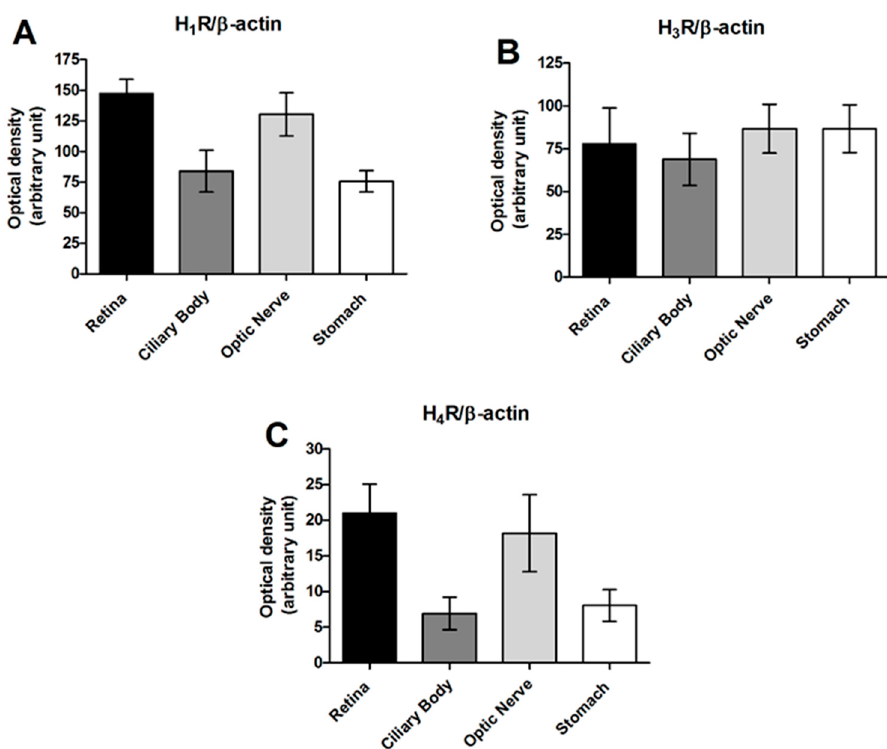
Figure 1. Western blot analysis of histamine H 1 R ( A ), H 3 R ( B ) and H 4 R ( C ) subtypes in the retina, ciliary body, optic nerve, and stomach samples of New Zealand White (NZW) rabbits. Densitometric data of 6 determinations are reported as relative optical density, corrected for the corresponding β -actin content [60] modified. Table 1. ( A ) Transient ocular hypertensive model and ( B ) carbomer-induced glaucoma model in male NZW